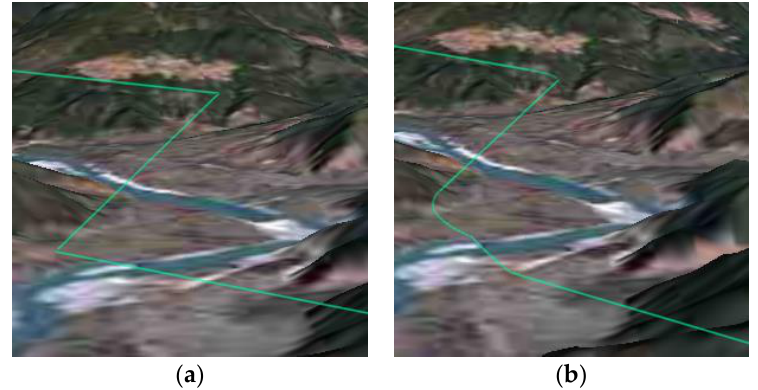
Figure 16. Turning, falling and rising corner adjustment. ( a ) Before turning corner adjustment; ( b ) After turning corner adjustment.